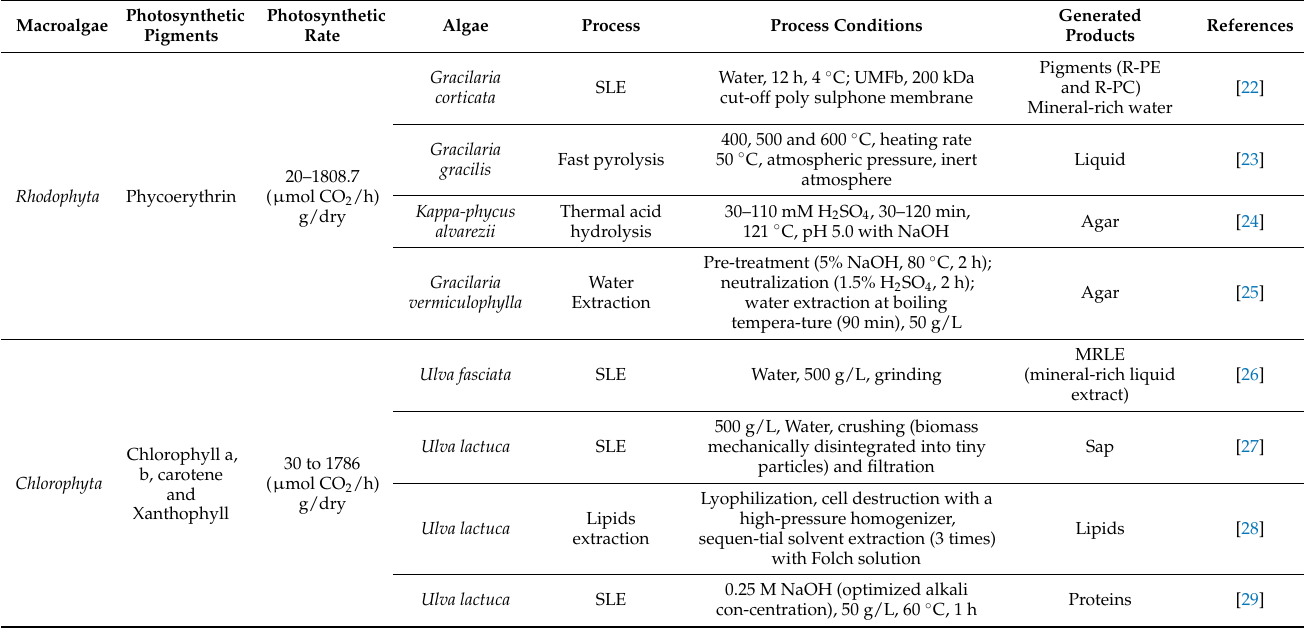
Table 1. Extraction and production of bioactive substances from macroalgae. Macroalgae Photosynthetic